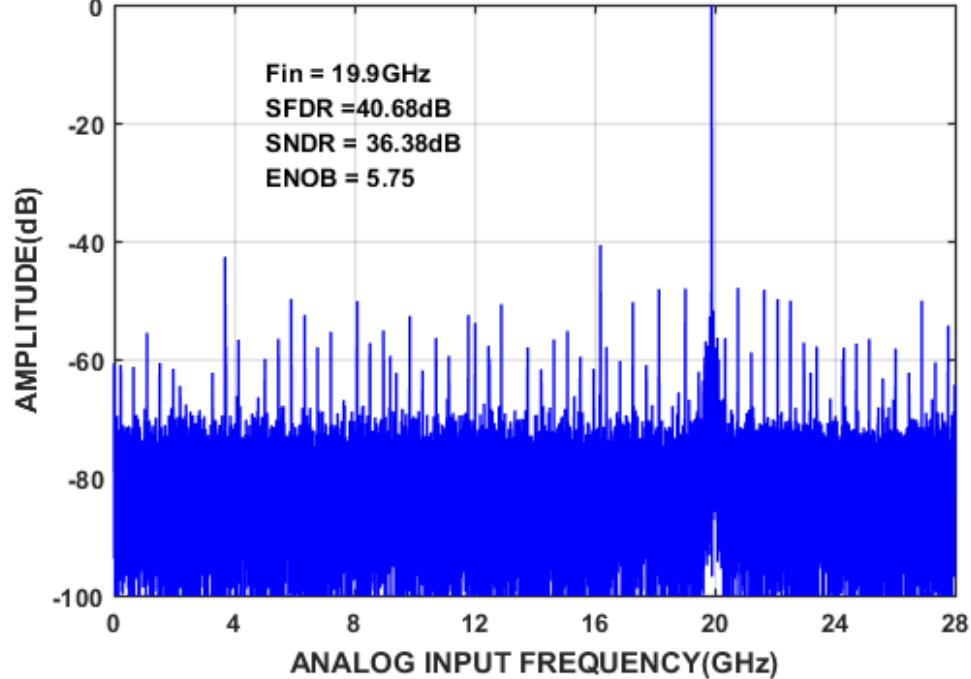
Figure 14. Measured output spectrum when the input frequency is 19.9 GHz at a 56 GS/s sampling rate.